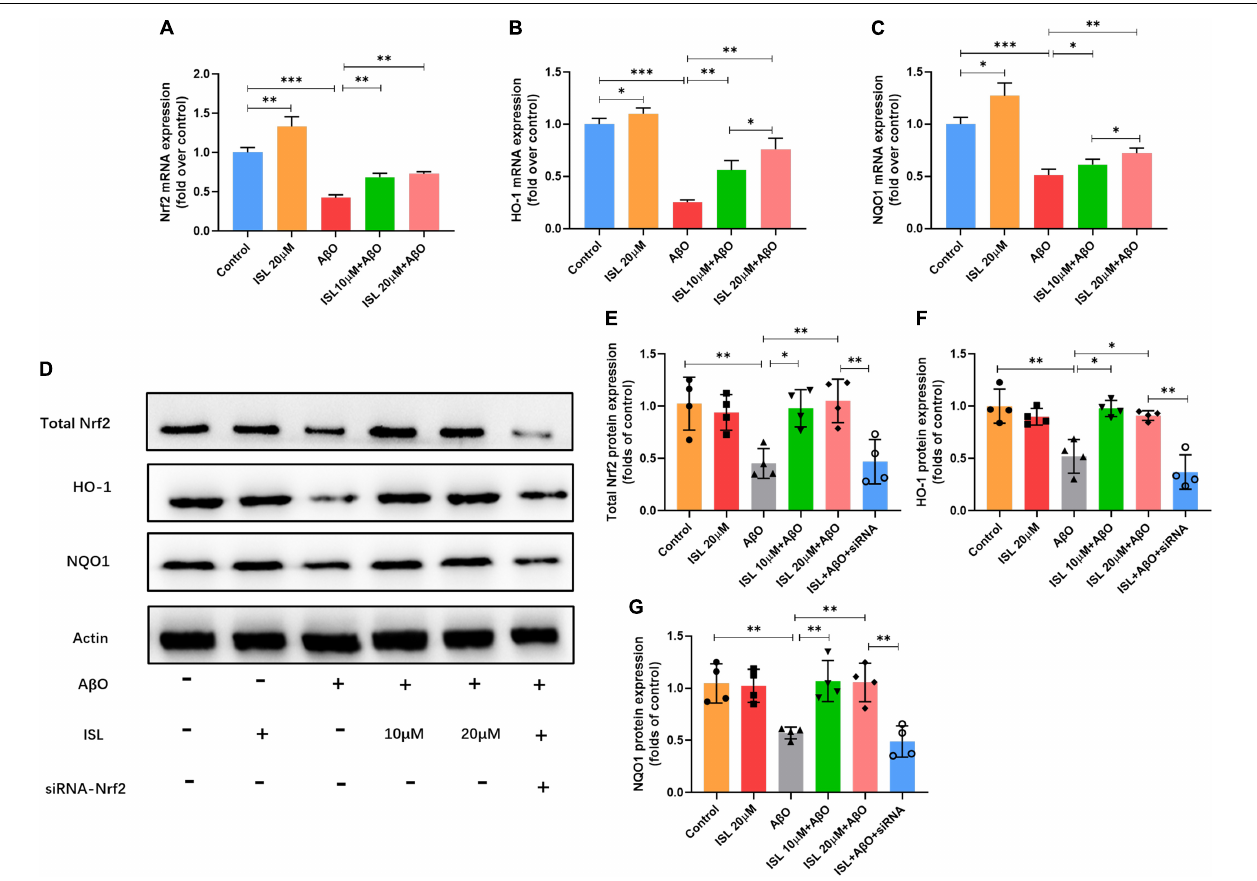
FIGURE 6 | ISL attenuates A β O induced suppression of the Nrf2 pathway. (A–C) BV2 cells were pre-treated with ISL for 2 h and then co-treated with 5 µ M A β O for 6 h. The mRNA levels of Nrf2, HO-1 and NQO1 were analyzed by qRT-PCR. (D–G) BV2 cells, including those transfected by Nrf2 siRNA, were pre-treated with ISL for 2 h and then co-treated with 5 µ M A β O for 24 h. Total protein expression of Nrf2, HO-1 and NQO1 were analyzed by Western blot. ∗ p < 0.05, ∗∗ p < 0.01, ∗ ∗ ∗ p < 0.001. n = 6 per group for qRT-PCR, n = 4 per group for Western blot.